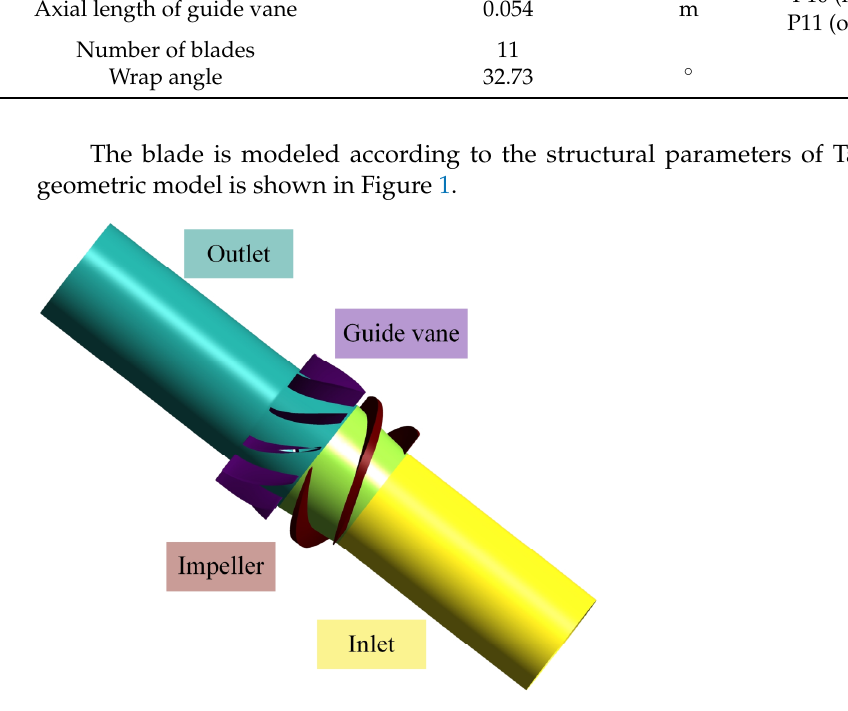
Figure 1. Model diagram of the impeller and guide vane of the multiphase pump.